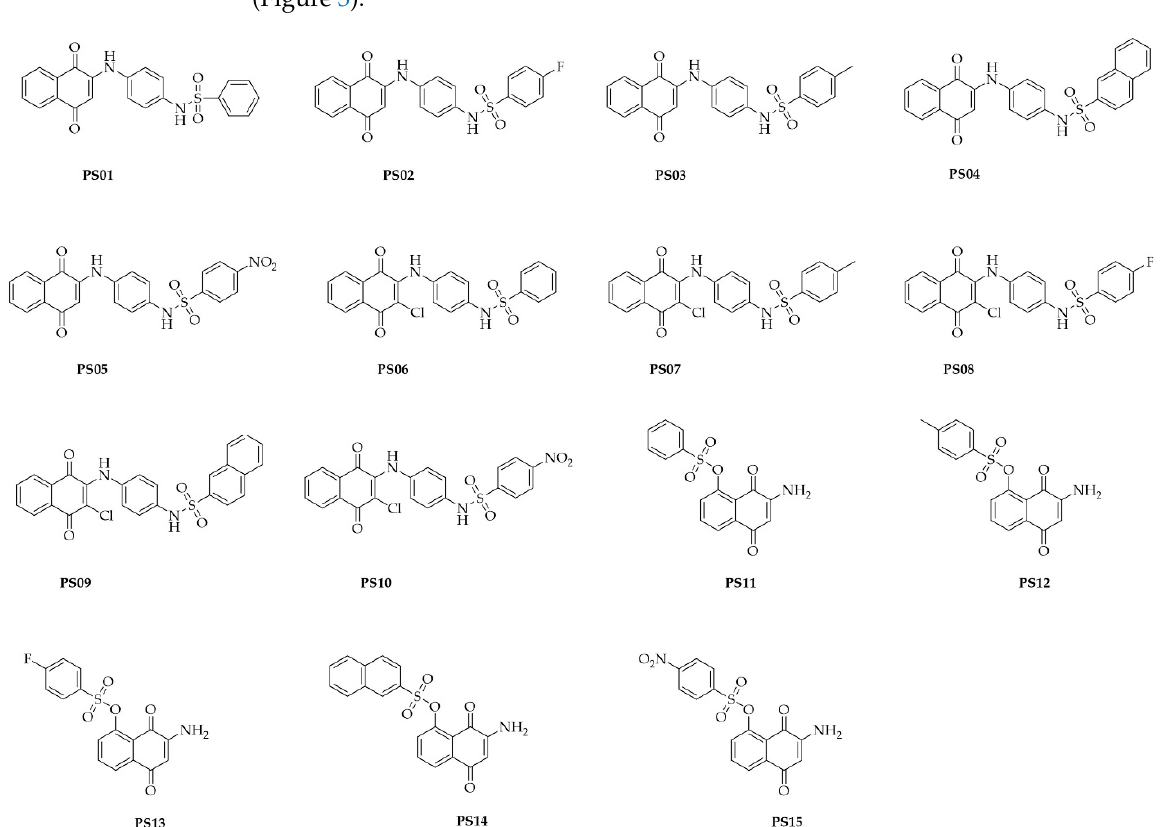
Figure 1. Chemical structures of naphthoquinone sulfonamide and sulfonate ester derivatives tested in this study .